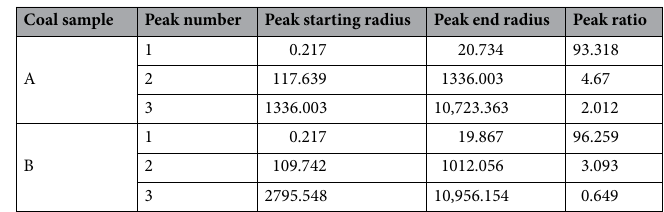
Table 3. Percentage ratio of each peak in pore size distribution.